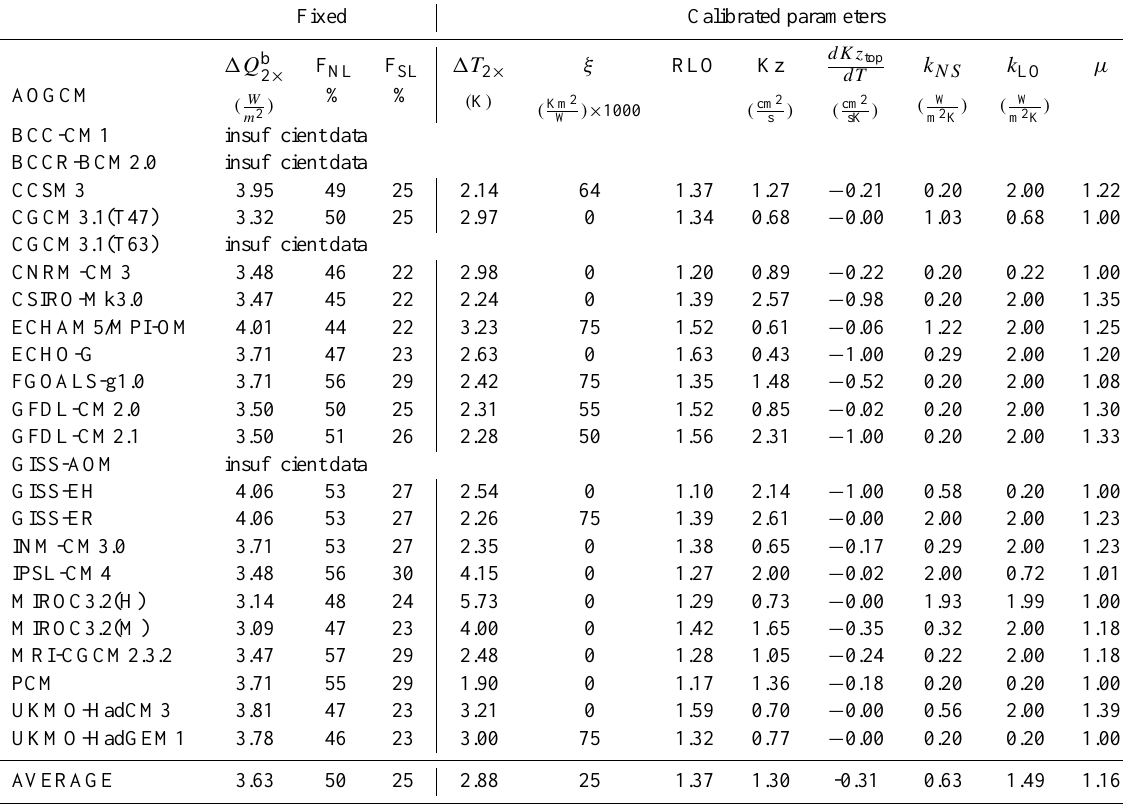
Table B3. AOGCM calibration III results: MAGICC6 parameters required to emulate CMIP3 AOGCM models using both idealized and multi-forcing runs with the same set of eight calibrated parameters as used in calibration II. The difference is that, here, fitting uses a wider range of climate scenario results. For a description of the calibrated parameters, see Table 1. The fixed parameters, provided here but used as fixed parameters in all three calibration methods, are 1Q 2 × , the AOGCM’s forcing at doubled CO 2 concentration levels, and the land area fractions on the northern (F NL ) and Southern Hemisphere (F SL